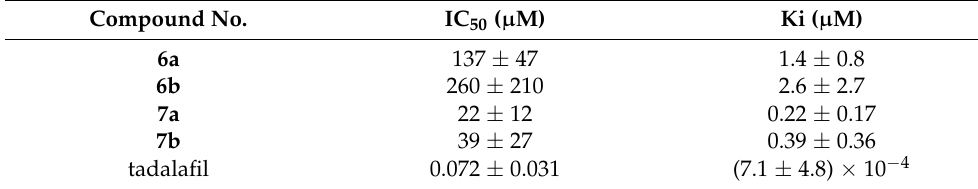
Table 2. Calculated IC 50 and Ki values of tadalafil and its analogues 6a,b , 7a,b against human PDE5. Compound